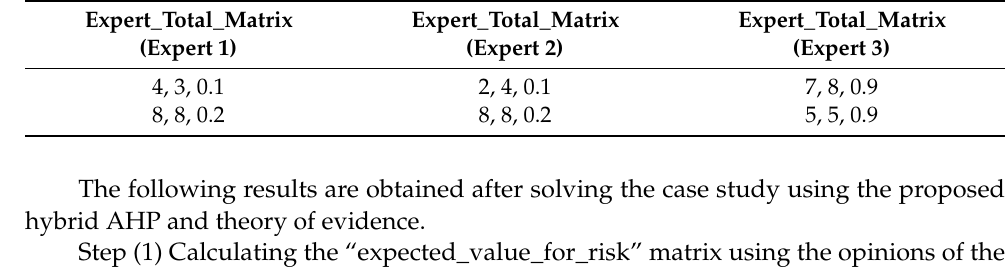
Table 9. Expert Opinion Total Matrix.